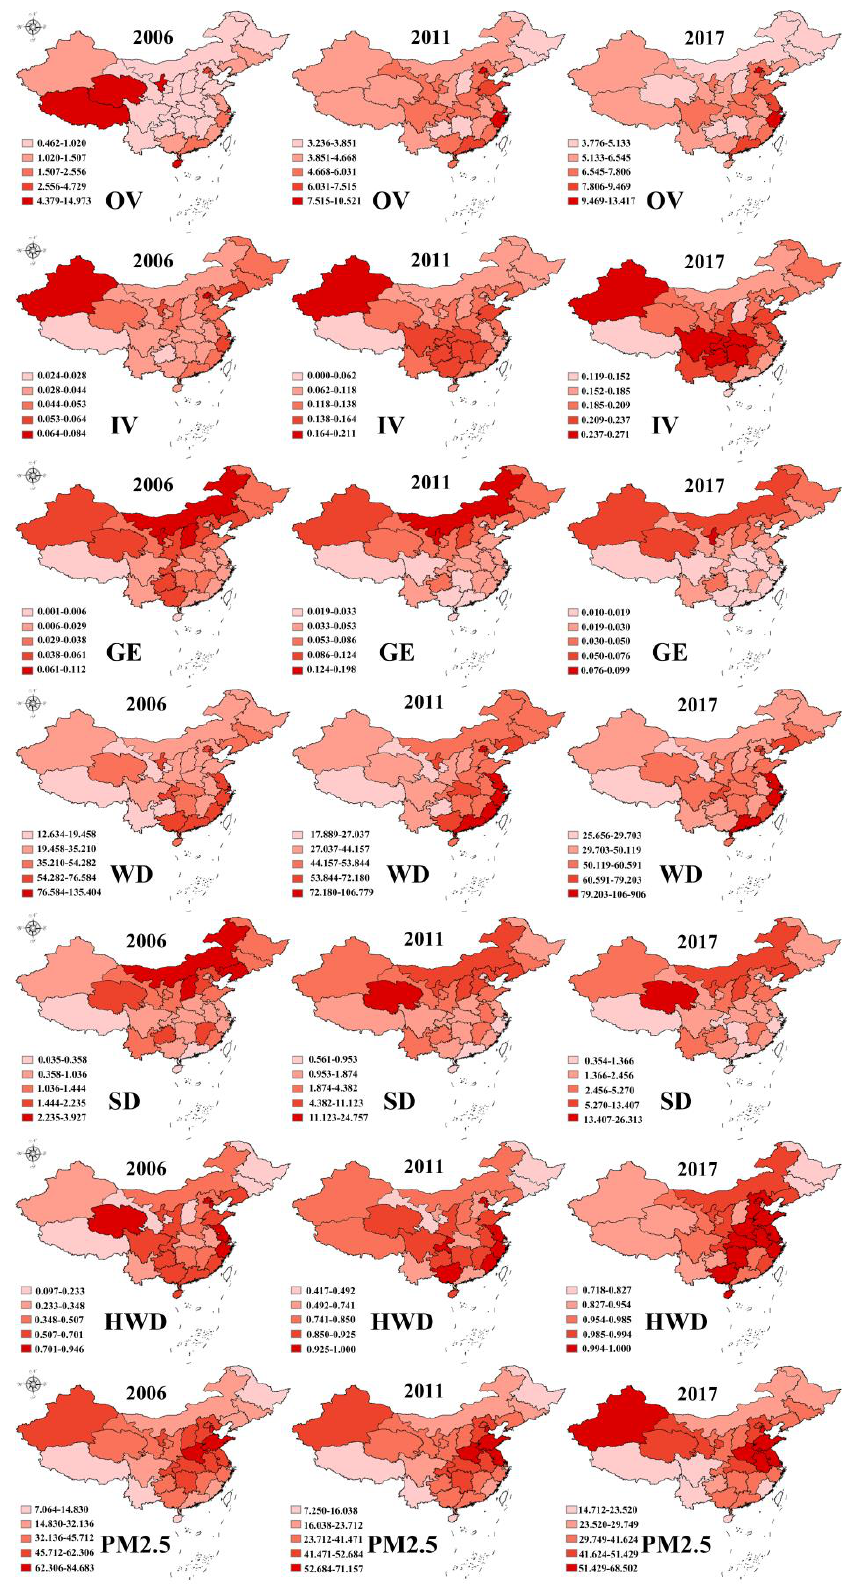
Figure 2. Hierarchical maps of the densities in health resources 1 . 1 OV: outpatient visits per capita; IV: inpatient visits per capital; ED: effluent discharge; GE: gas emission; SD: solid discharge; PM2.5: average PM2.5 concentration; HWD: household waste disposal.